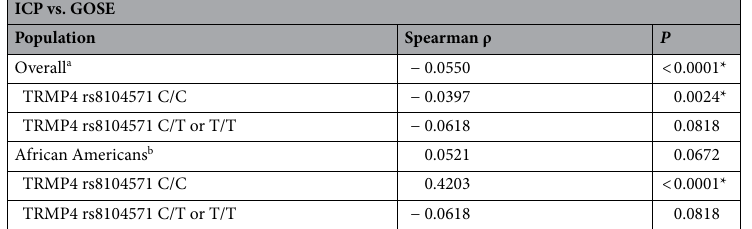
Table 5. Spearman correlation analysis between intracranial pressure and Glasgow outcome scale-extended stratified by TRMP4 rs8104571 genotype. C cytosine, T thymine, ICP Intracranial pressure, recorded within 5 days of admission; a Overall study population: 7444 total ICP measurements (C/C: 6573; C/T: 803; T/T: 68); b African-American study population: 1311 total ICP measurements (C/C: 440; C/T: 803; T/T: 68); GOSE Glasgow outcome scale-extended, recorded on first follow-up visit; *Significant P values < 0.05.